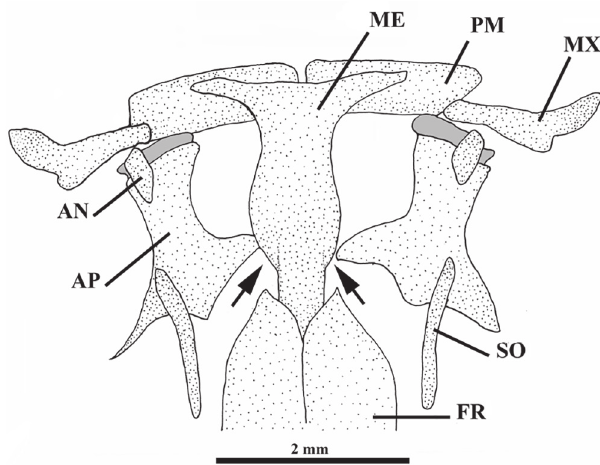
Fig. 3. Ituglanis inusitatus , new species, paratype, UFRGS 20201, 70.2 mm SL, c&s. Dorsal view of mesethmoid (ME), premaxilla (PM), maxilla (MX), tendon-bone supraorbital (SO), frontal (FR), autopalatine (AP), and antorbital (AN). Arrows indicate the enlargement at middle portion of mesethmoid. Gray area represents cartilage. Scale bar = 2 mm.